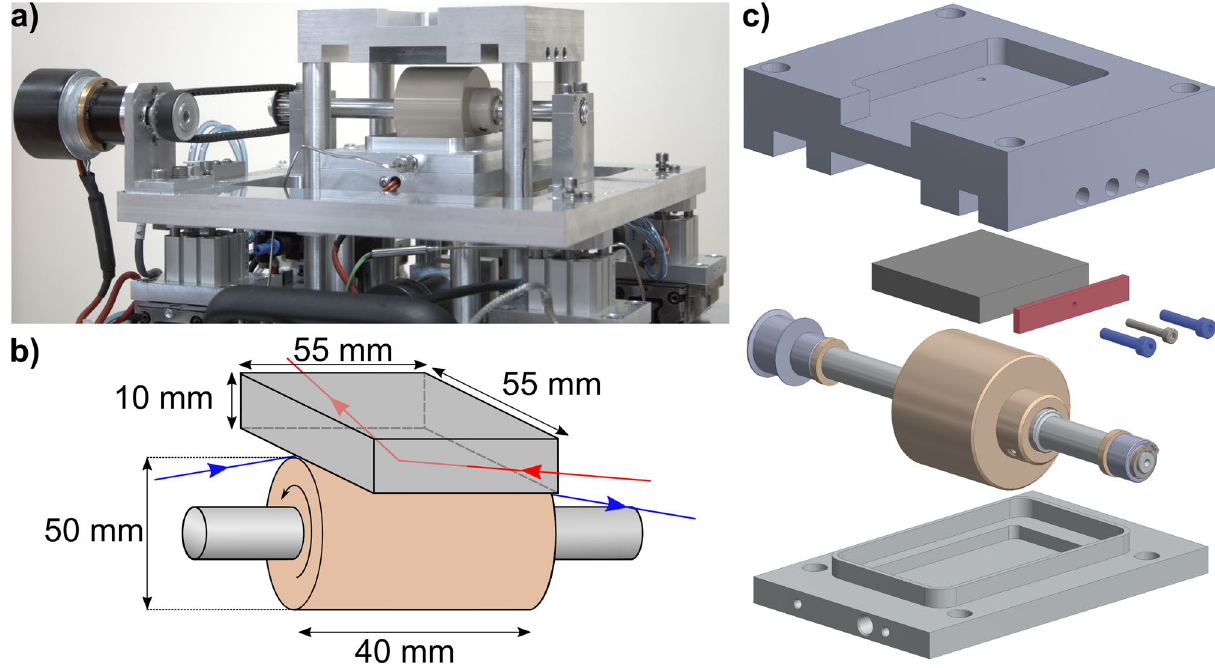
Figure 2. Visual overview of the tribometer. ( a ) Diagonal view of the tribometer in the lowered position. ( b ) A schematic of the roller and substrate at the centre of the tribometer. The red and blue arrows depict the approximate paths for the neutron and X-ray beams respectively. ( c ) Exploded view of the centre of the tribometer. The two screws (blue) in the head unit force the gib strip (red) against the substrate, securing it above the roller.